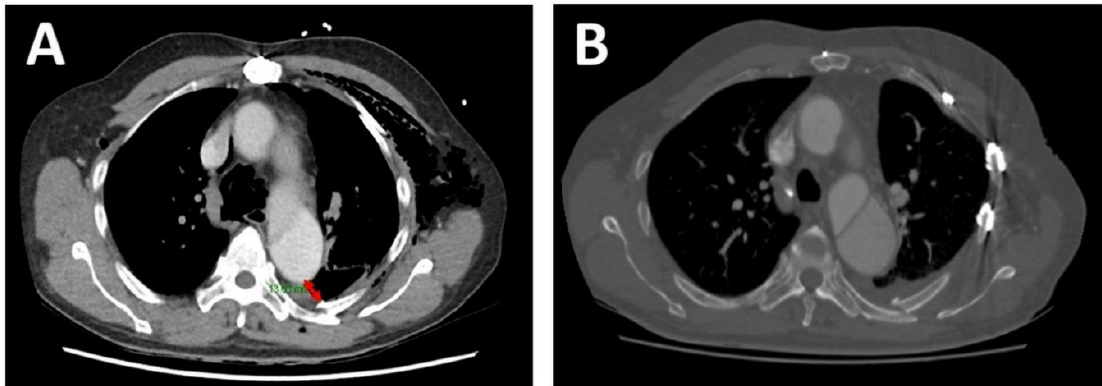
Figure 3. Chest CT (axial view)—preoperative and 6-week postoperative images. ( A ). Preoperative chest CT demonstrat- ing the proximity of the sixth rib fracture site to the false lumen of the aorta (~13 mm as marked by the double-tipped red arrow). ( B ). 6-week postoperative chest CT showing in situ RibFix TM plates.